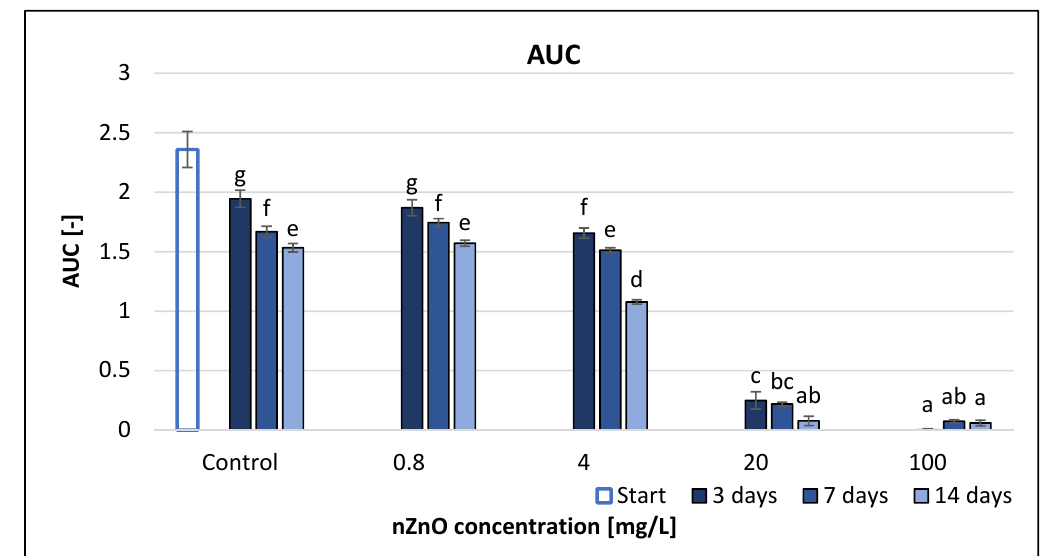
Figure 2. The effect of ZnO nanoparticles on freshwater area under the curve value. Letters on the columns indicate significant differences (level of significance: p < 0.05).